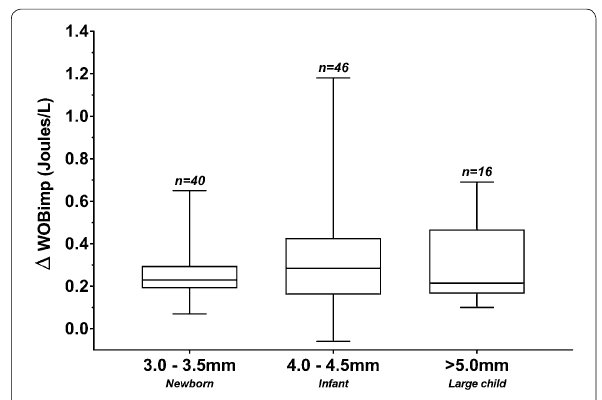
Fig. 2 Difference in imposed work of breathing (∆WOBimp) expressed in Joules/L during extubation readiness testing using continuous positive airway pressure (CPAP) with or without added pressure support (PS) stratified by endotracheal tube (ETT) size. Data are shown as median (IQR)